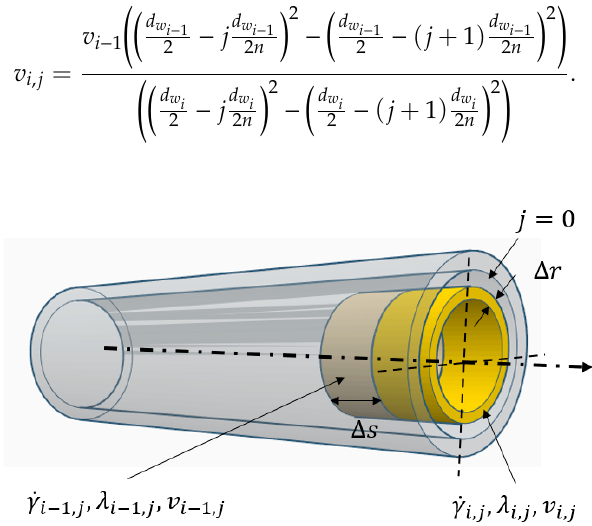
Figure 18. Representation of the structure parameter as a function of the normalized radial position and axial distance after the pressure relief valve. The color scale is gradient based. The axial evolution of the structure parameter impacts in turn the relationship between the shear stress and shear rate. As the shear stress needs to be a linear function of the radial position (to the